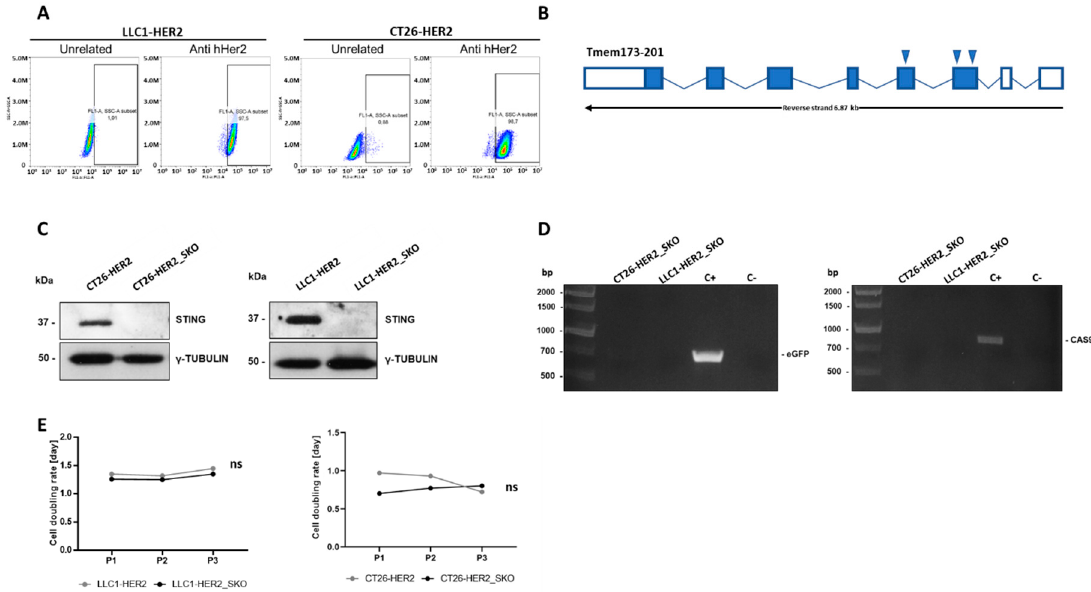
Figure 1. Molecular characterization of Sting knockout cancer cell lines. ( A ) Analysis of human HER2 display on cell surface of LLC1-HER2 (left) and CT26_HER2 (right) by FACS analysis; an unrelated antibody was used as negative control. ( B ) The graphic shows Tmem173 (transcript ID ENSMUST00000115728.4) gene organization. Full and empty boxes represent, respectively, coding and untranslated exons. The positions of guide RNAs used for CRISPR / Cas9 genome editing to generate Sting knockout cancer cell lines are indicated by arrows. ( C ) Western blot analysis of Sting protein in CT26-HER2, LLC1_HER2 and their Sting knockout cell lines counterparts. Gamma tubulin was used as standard. ( D ) PCR screening of CT26-HER2_SKO and LLC1_HER2_SKO cell lines to assess the absence of eGFP and Cas9 residues in genomic DNA. Cas9 / eGFP-encoding vector was used as positive control (C + ). Genomic DNA from parental CT26-HER2 and LLC-HER2 cell lines was used as negative control (C − ). ( E ) Cell doubling per day were assessed for Sting wild-type (grey lines) and Sting knockout (black lines) LLC1 (left) and CT26 (right) cell lines. The di ff erences in cell doubling were calculated by Student’s t -test and were not statistically significant (Ns) to each passage.